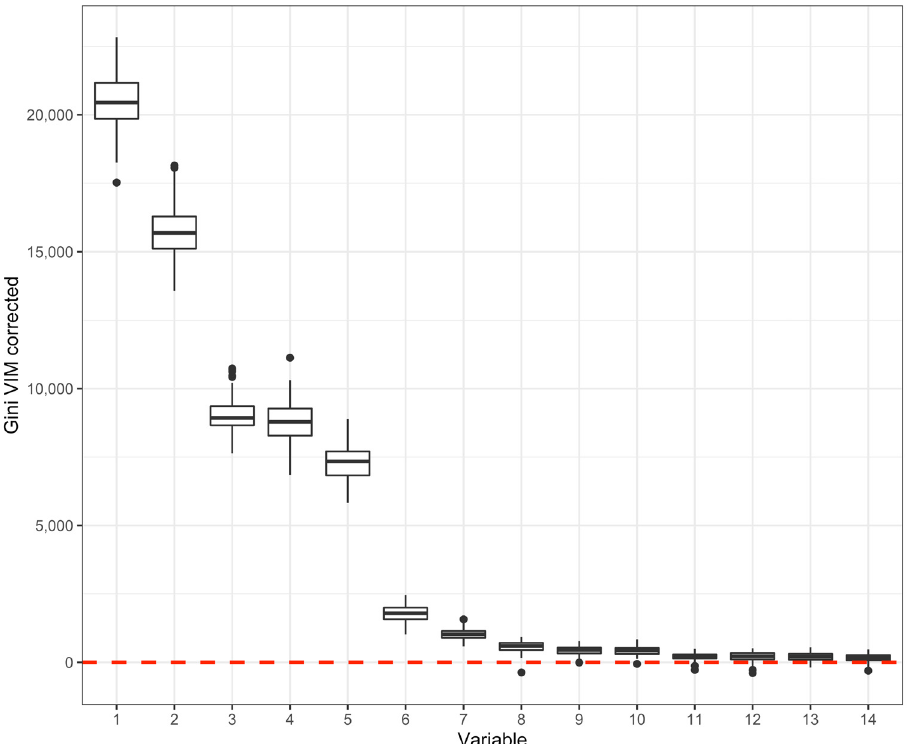
Figure 1. Random forest regression Gini corrected VIM. Legend: (1) Shots_OT; (2) Possession; (3) Shots; (4) Shots_Conceded; (5) Pass_Success; (6) Dribbles; (7); Arials_Won; (8) Offsides; (9) Tackles; (10) Yellow_Cards; (11) Red_Cards; (12) Fouled; (13) Interceptions; (14) Fouls.